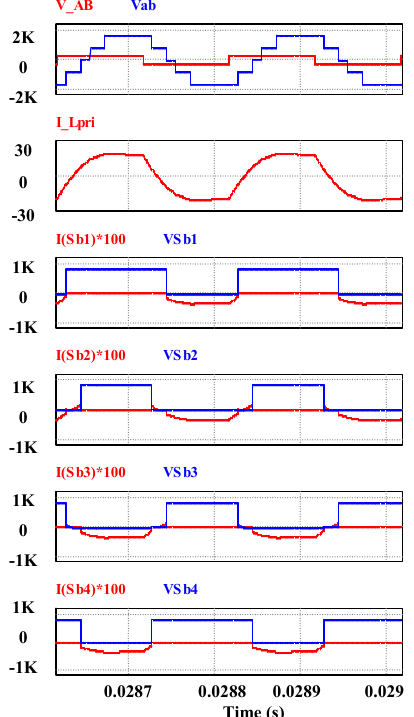
Figure 14. Voltage across the transformer (cid:1874)